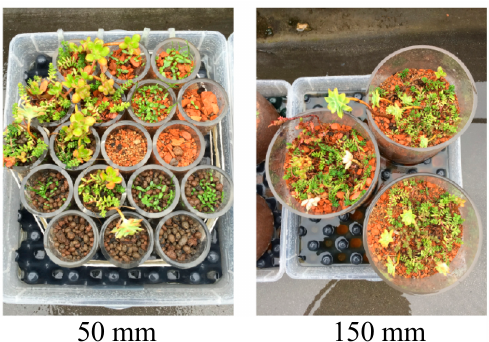
Figure 2. Two microcosm sizes. The 150 mm examples are BBS with Sedum vegetation. Image taken 7 October 2015.